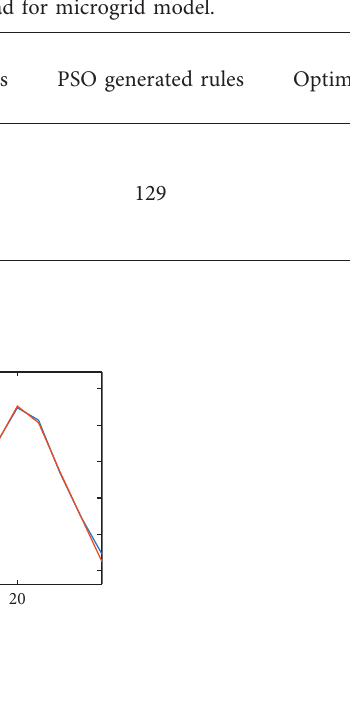
Figure 30: The Fuzzy-PSO prediction of the total system load for microgrid Table 7: Performance evaluation of fuzzy-alone and Fuzzy-PSO load prediction model based on MAPE. No.